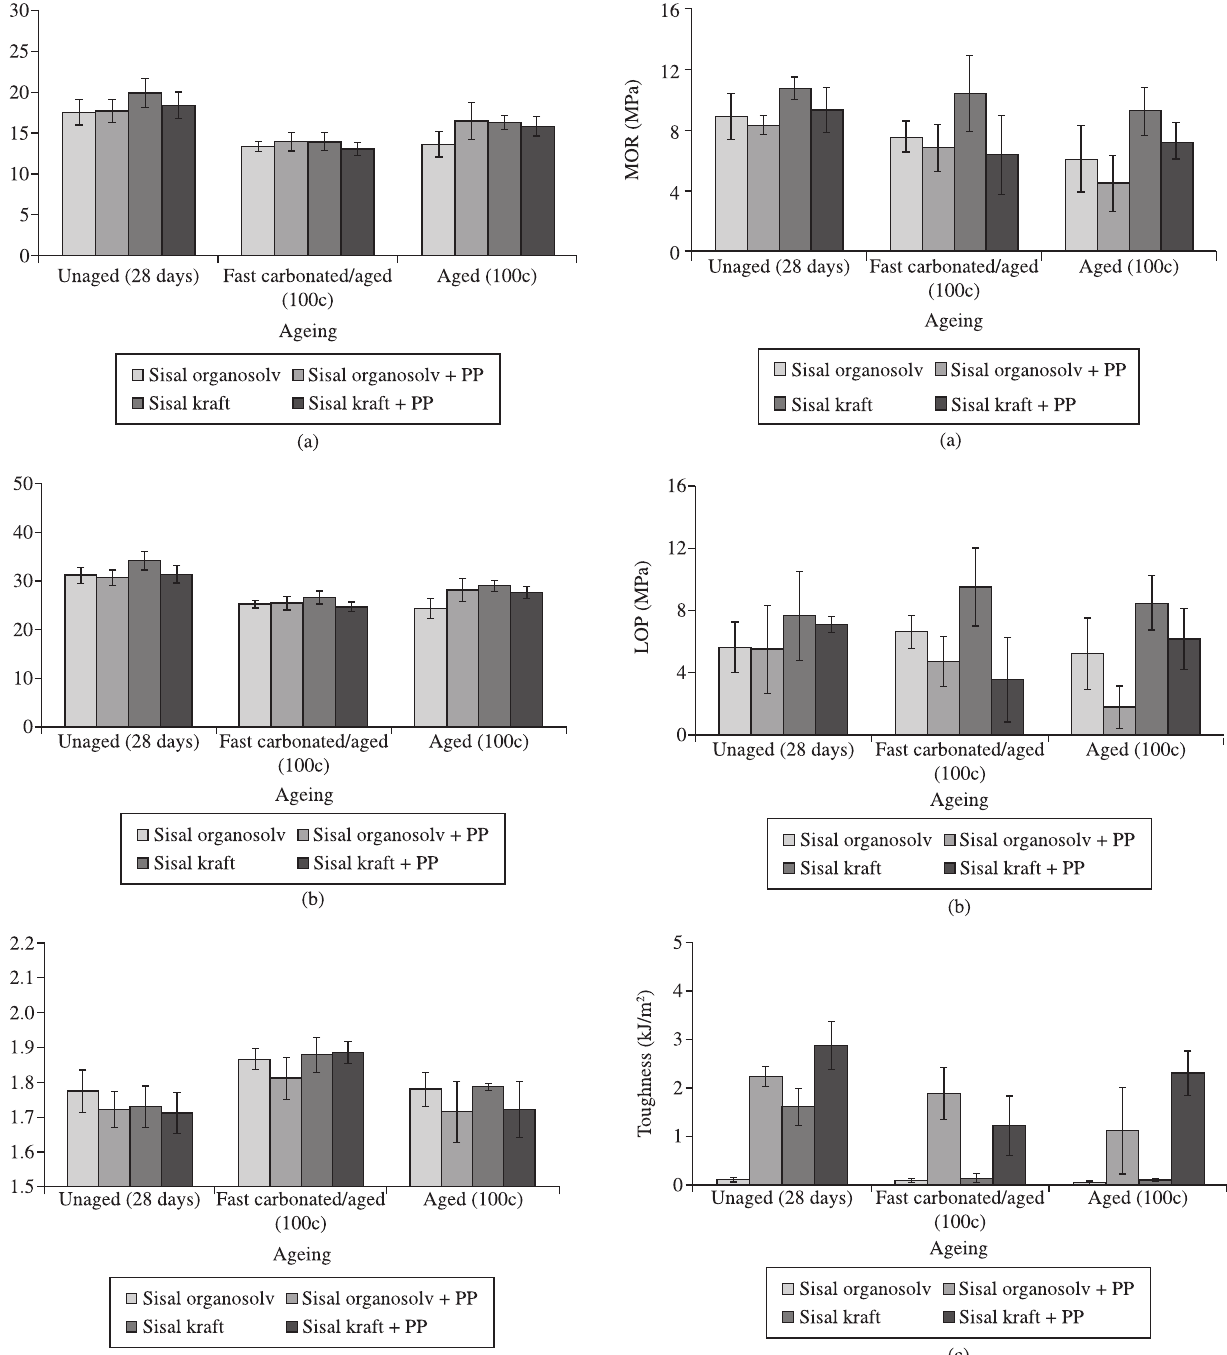
Figure 6. Mechanical properties of the composites reinforced with sisal or- ganosolv and PP fibres at 28 days, fast carbonated/aged and aged. a) MOR, b) LOP and c)